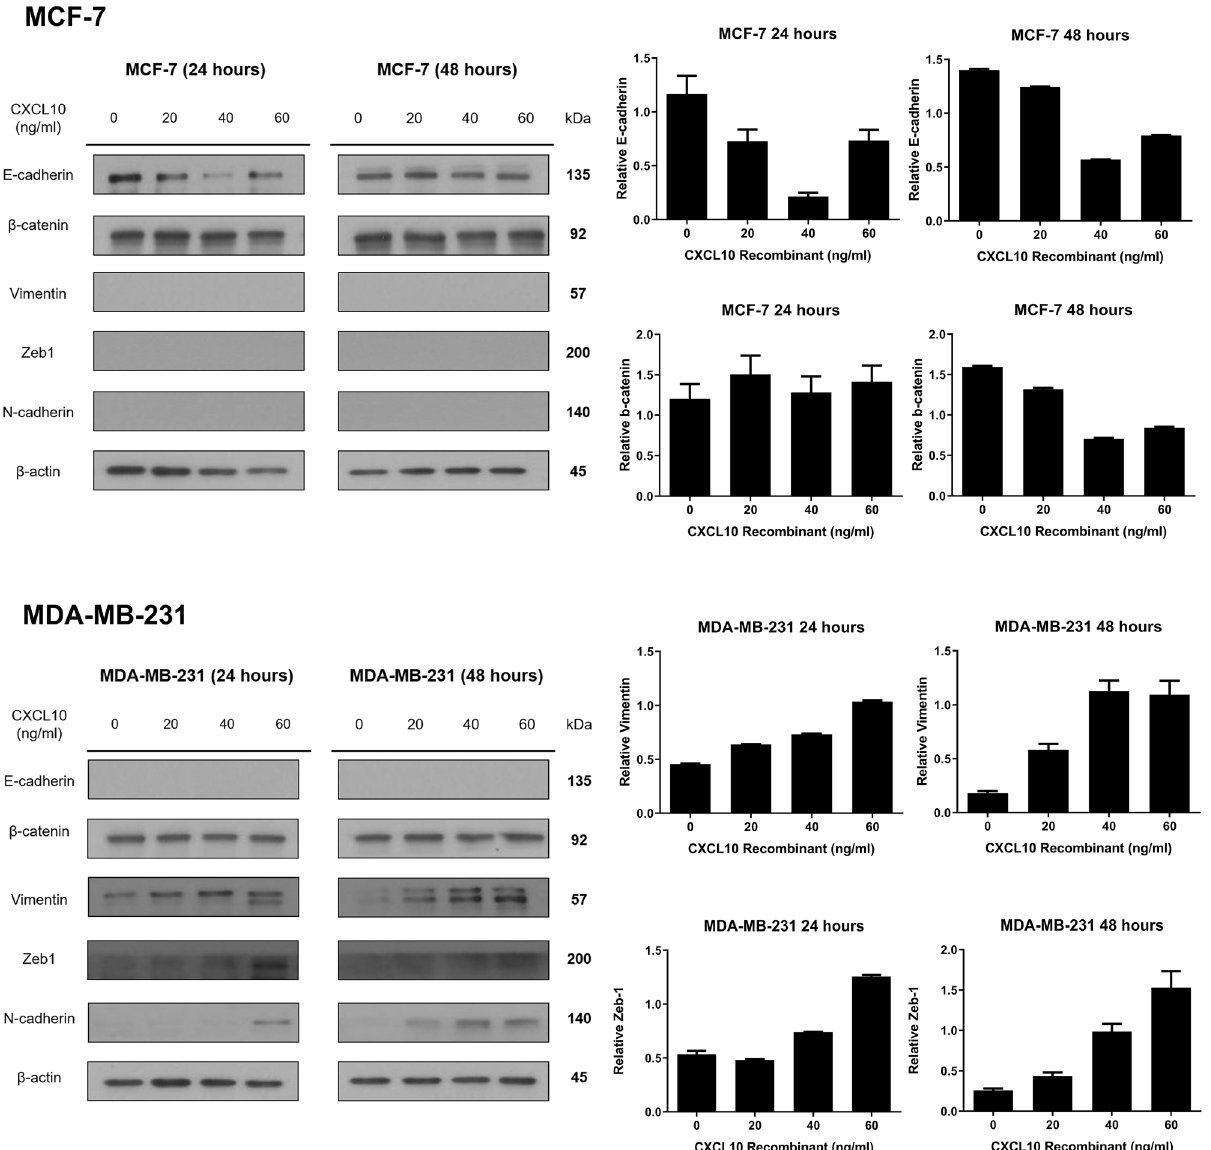
Figure 4. Western blot of epithelial-mesenchymal transition-related markers with CXCL10 treatment. In MCF- 7, expression of E-cadherin decreased with an increased dose of CXCL10. Mesenchymal markers- β-catenin, vimentin, Zeb1 and N-cadherin—did not show any expression regardless of the dose of CXCL10 added to the sample. Western blot assay showed increased expression of vimentin, Zeb1, and N-cadherin expression with an increased dose of CXCL10 in MDA-MB-231. There was no E-cadherin expression in MDA-MB-231. *Statistically significant. The graphs were created using GraphPad Prism version 8.02 for Windows (GraphPad Sofware, San Diego, CA, USA, www. graph pad. com). Full length blots are presented in Supplementary Figure